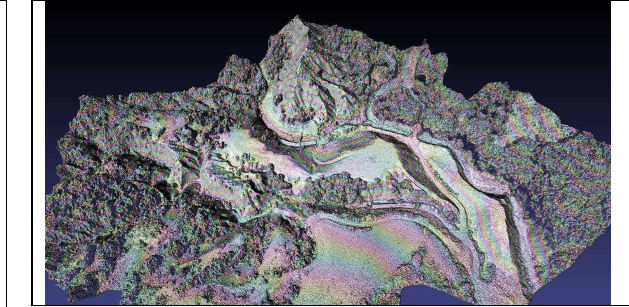
Figure 4. .Modelisation of terrain of Draix for soil erosion application.